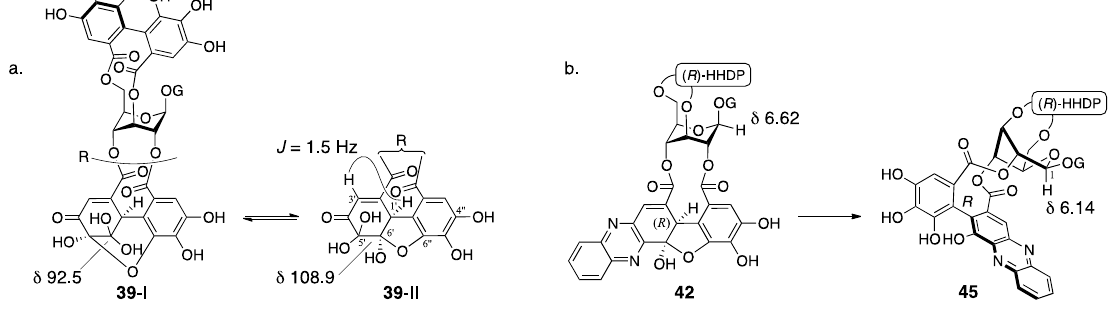
Figure 24. The transformations used for the determination of the first structure of terchebin ( 54 ). Consideration of the 1 H-NMR spectrum of terchebin caused Schmidt to become aware of the error in the structure 54 . The 1 H-NMR spectrum of terchebin in DMSO- d 6 did not show any signal due to the –CH 2 – group that was in the cyclohexane-trione ring in 54 . Moreover, signals from groups, such as the hydroxy groups other than those of phenol, H-2 ′ , H-3 ′ , and H-3 ″ , were observed as ½ H integrated intensity (Figure 25). According to the observations, Schmidt presumed the diastereomeric mixture 61 for the iso -HHDP moiety. With the knowledge of the revisions of the structurally related